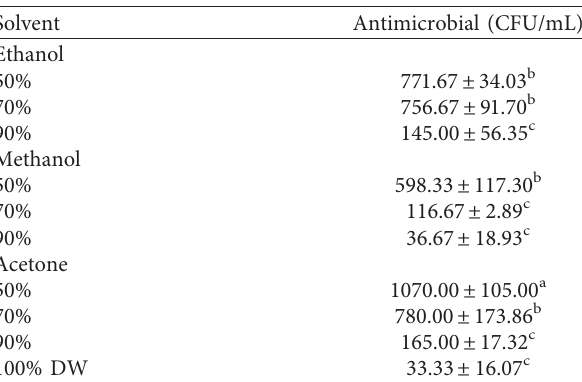
Figure 2: HPLC trace of phenolic compounds extracted from olive leaves with 90 vol% methanol: (A) hydroxytyrosol, (B) tyrosol, and (C) oleuropein. Table 3: Total viable counts (TVCs) in olive leaf extracts obtained using various solvents.